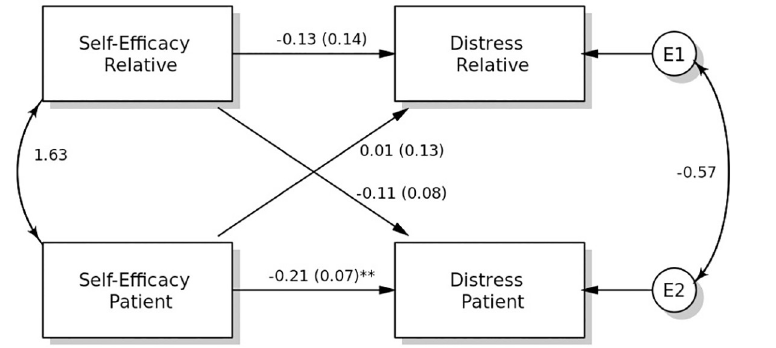
Fig 1. The standard model for self-efficacy on